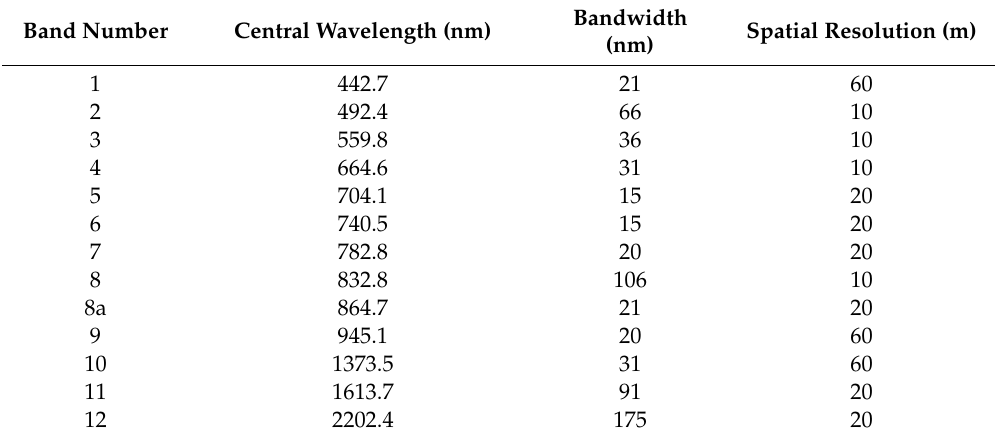
Table 1. Spectral bands for the Sentinel 2A